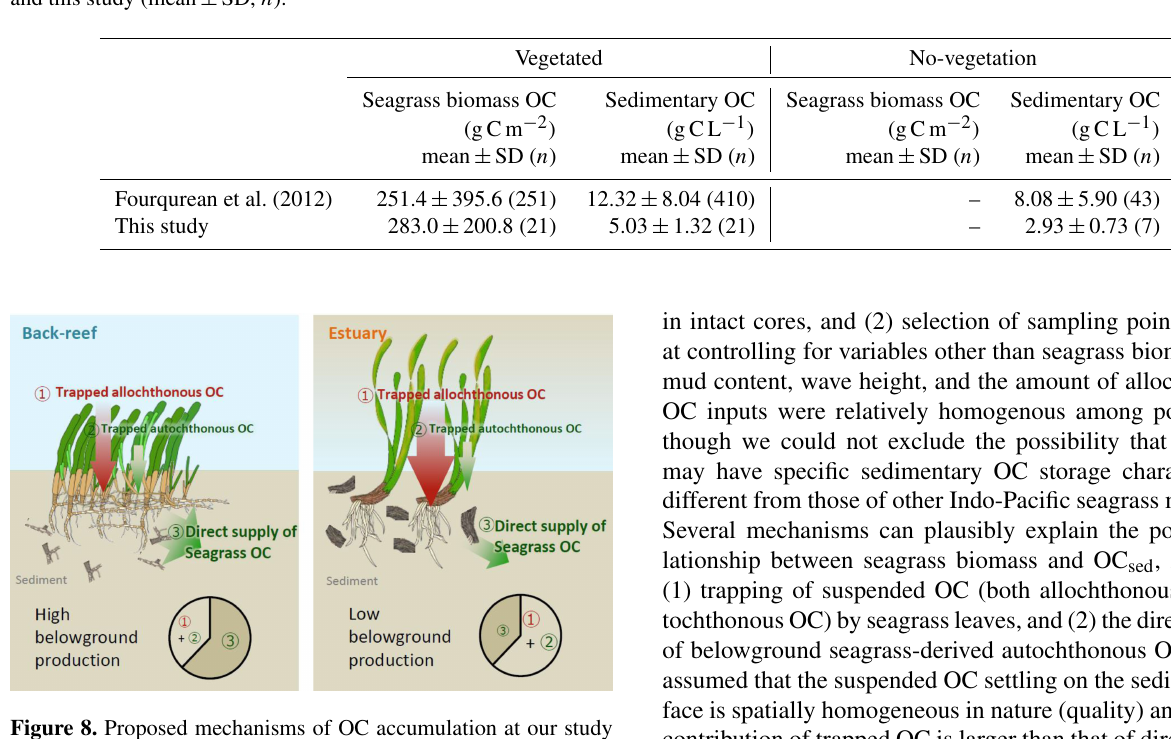
Table 3. Values of seagrass biomass organic carbon and sedimentary organic carbon mass in globally compiled data (Fourqurean et al., 2012) and this study (mean ± SD, n ).